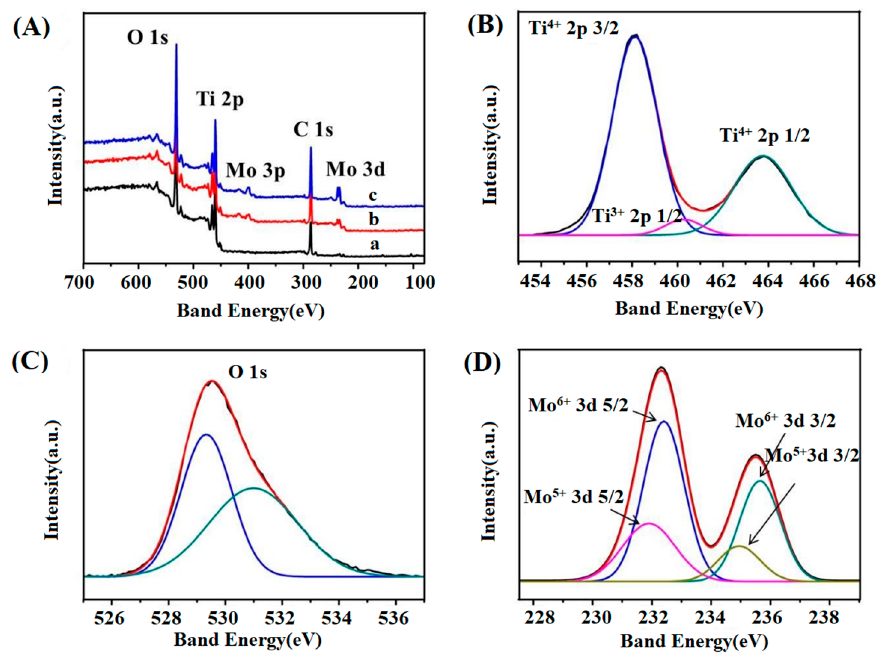
Figure 4. Wide-survey XPS spectra ( A ) of TiO 2 (a-Mo0) and Mo-doped TiO 2 nanotube arrays (b-Mo0.5, c-Mo1.0), the high-resolution XPS scan of Ti 2 p ( B ), O 1 s ( C ) and Mo 3 d ( D ) of 0.5 at.% Mo-doped TiO 2 nanotube arrays (b-Mo0.5).